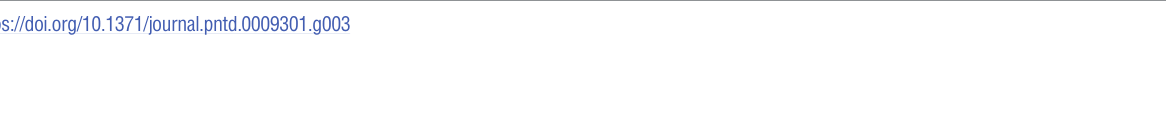
PLOS NeglectedTropical Diseases | https://doi.org/10.1371/journal.pntd.0009301 March 29, 2021 8 /